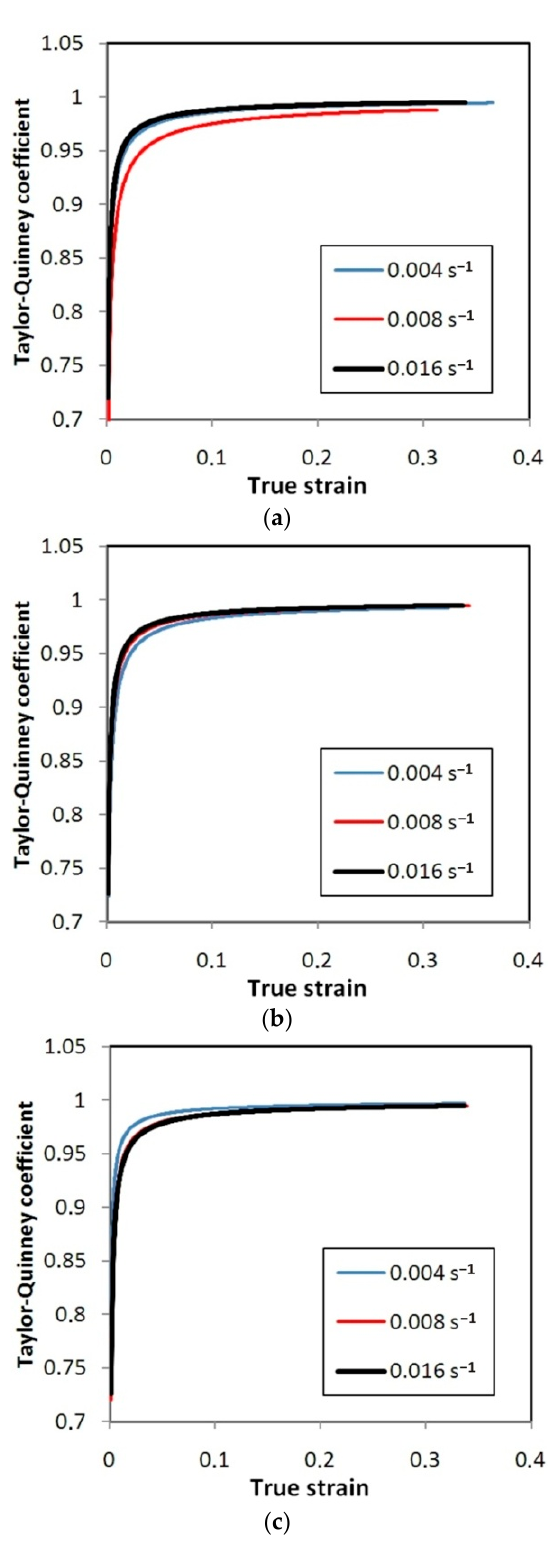
Figure 22. Variation of the Taylor–Quinney coefficient vs. true strain for HX specimens oriented at: ( a ) 0°, ( b ) 45° and ( c ) 90°.